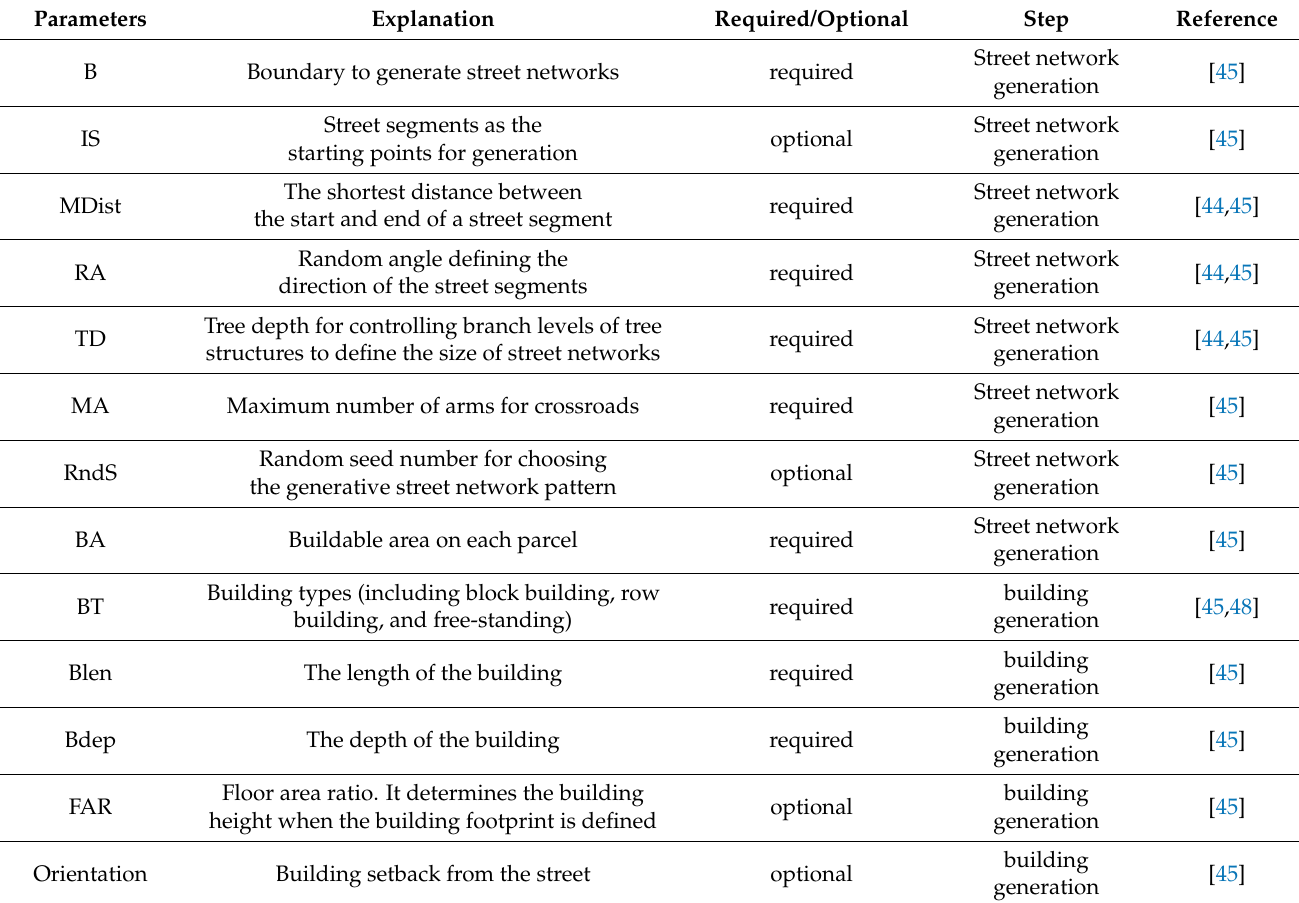
Table 3. The information of input parameters in generative urban design